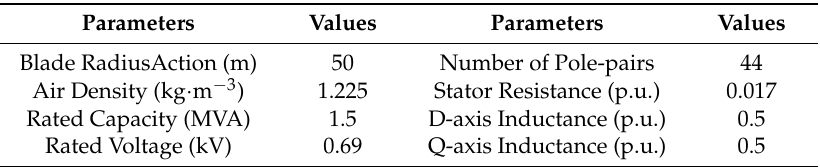
Table 1. Parameters of the PMSG-based